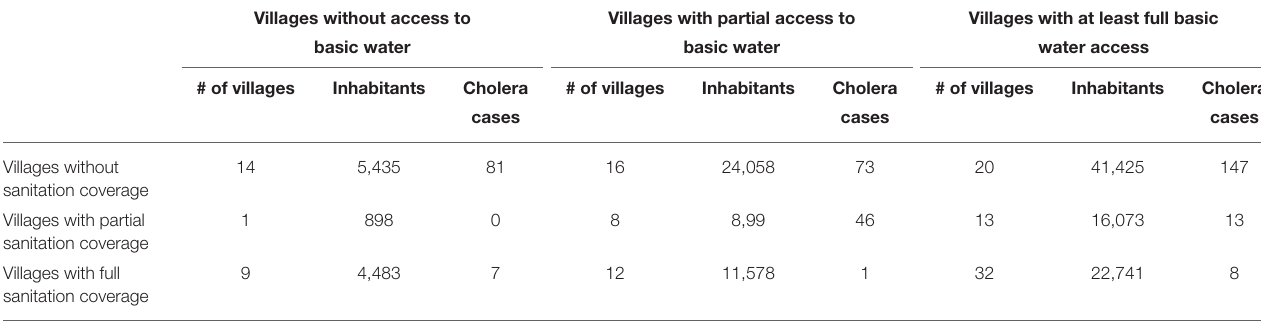
TABLE 1 | Number of villages, inhabitants, and cholera cases based on their basic water access levels and Community-Led Total Sanitation (CLTS) coverage levels. Villages without access